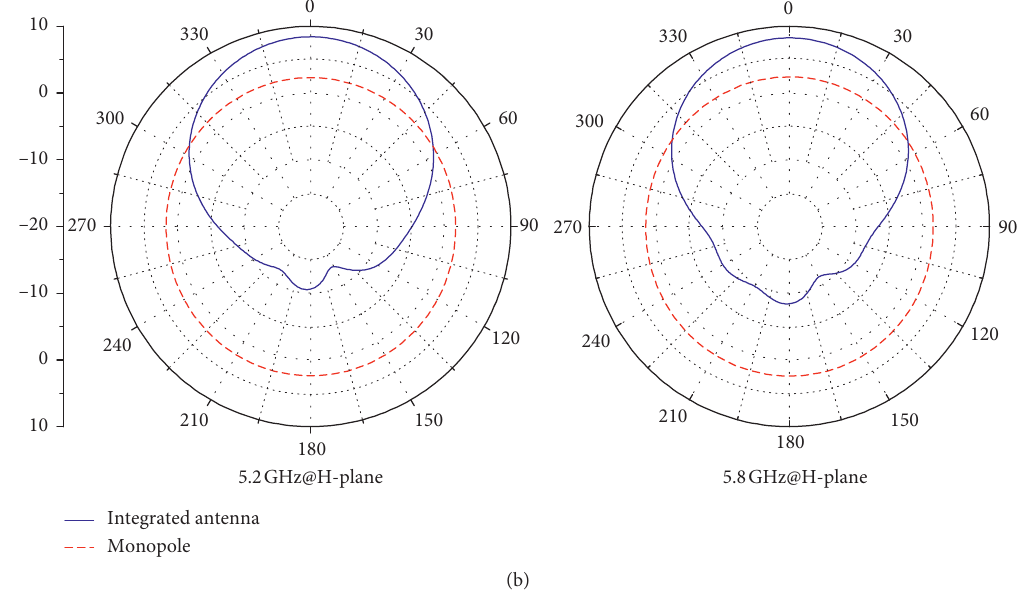
Figure 4: E- and H-plane gain total radiation patterns at working frequency.